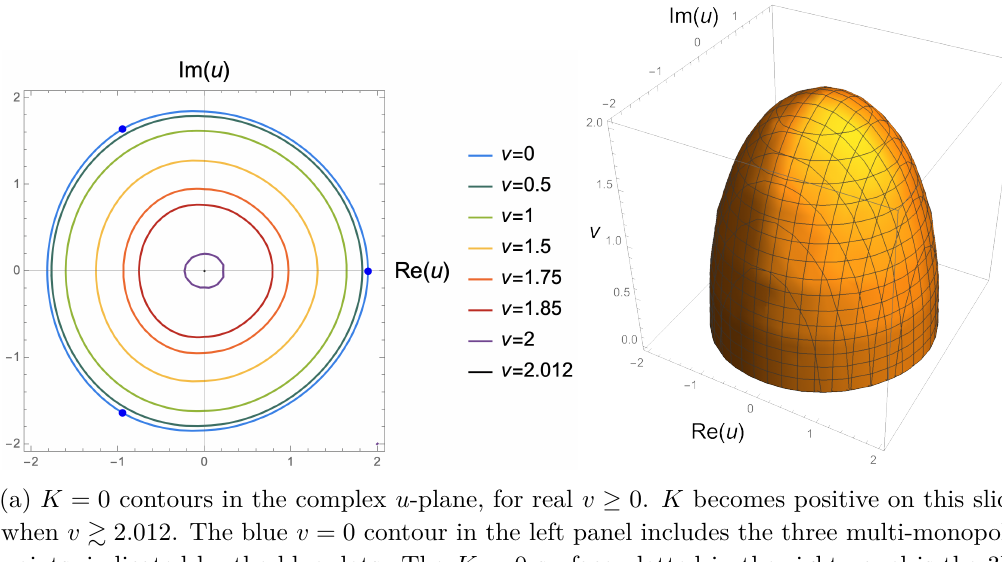
(a) K = 0 contours in the complex u -plane, for real v when v & 2 . 012 . The blue v = 0 contour in the left panel includes the three multi-monopole points, indicated by the blue dots. The K = 0 surface plotted in the right panel is the 3D visualization of the contours plotted in the left panel, and is symmetric under v